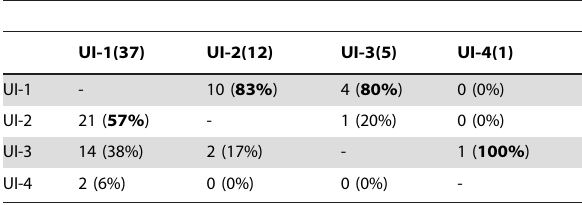
Table 3. Statistical results of user interface(UI) evaluation from 55 participants.